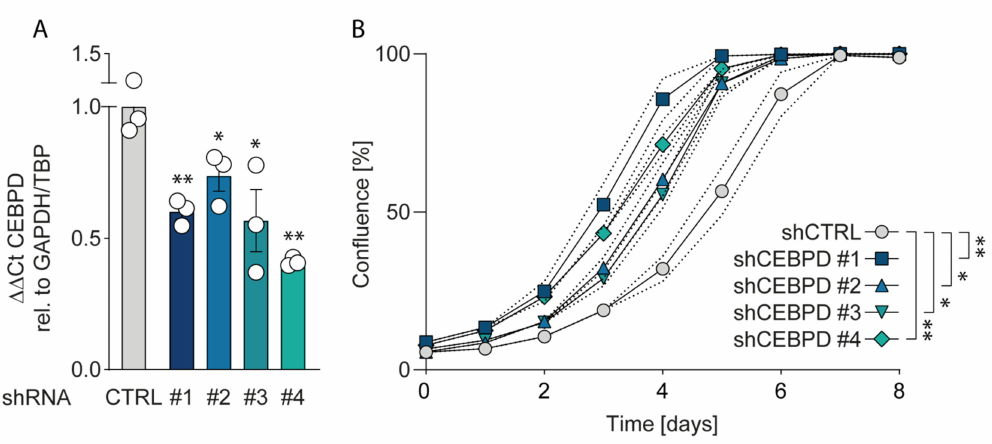
Figure 6. Silencing C / EBP δ enhances proliferation of Capan-2 cells. ( A ) Quantitative RT-PCR shows decreased levels of CEBPD mRNA in Capan-2 cells stably expressing shRNAs against CEBPD. ( p = **0.0058, *0.0429, *0.0338 and **0.001 for shCTRL vs. shCEBPD #1, #2, #2 and #4, respectively). ( B ) Proliferation of CEBPD -silenced Capan-2 cells is significantly increased compared to control cells. ( p = **0.0013, *0.011, *0.0146 and **0.0013 for shCTRL vs. shCEBPD #1, #2, #2 and #4,